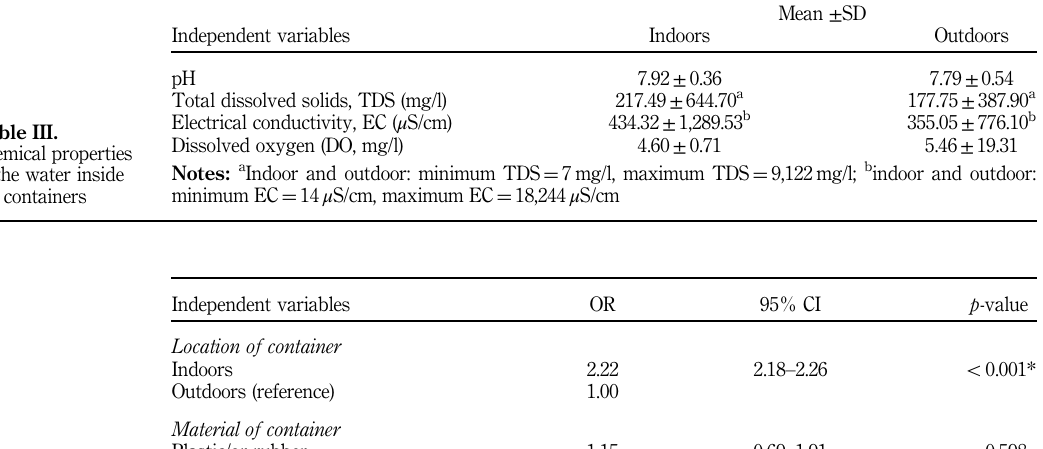
Table IV. Binary logistic regression analysis of characteristic factors of water containers influencing the presence of Aedes mosquito